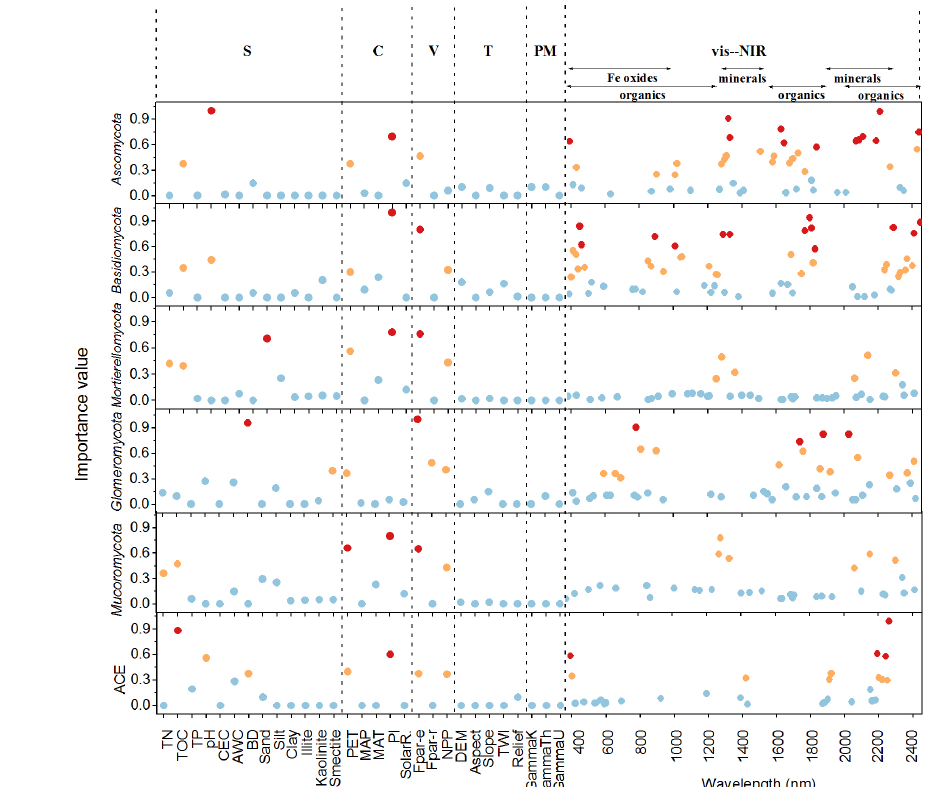
Figure 5. Important predictors of relative abundance of fungal phyla and diversity index measured by the variable importance of the 1D- CNNs spectrotransfer functions ( n = 577) derived with publicly accessible data that represent soil (S), climate (C), vegetation (V), terrain (T), parent material (PM) and vis–NIR spectra. The dots in red, orange and blue indicated the most, medium and least important levels. The importance value for the majority of wavelengths were low and close to zero, thus these wavelengths were not shown to make the figure